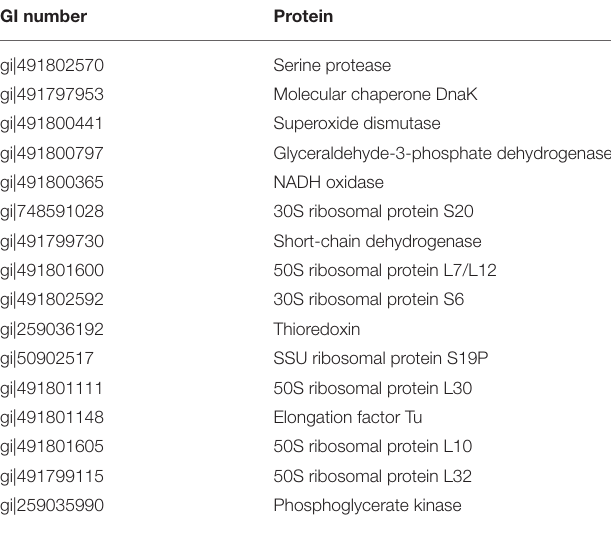
TABLE 1 | List of G. adiacens secretome proteins with a predicted moonlighting